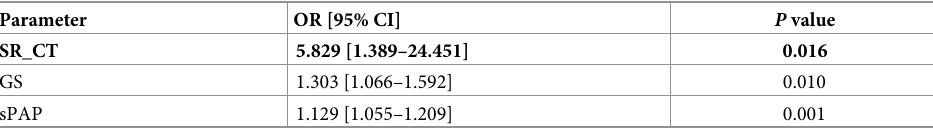
Table 7. Predictors of HFpEF in multivariate logistic regression.